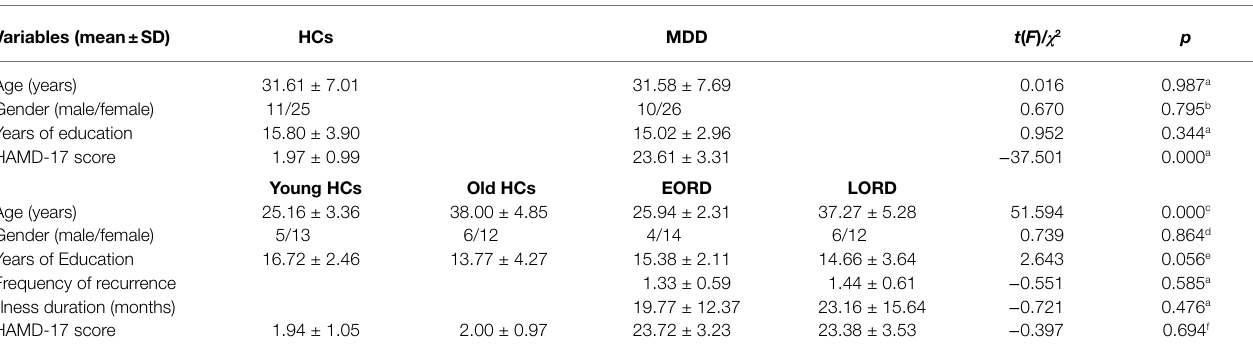
TABLE 1 | Demographic and clinical characteristics of the study